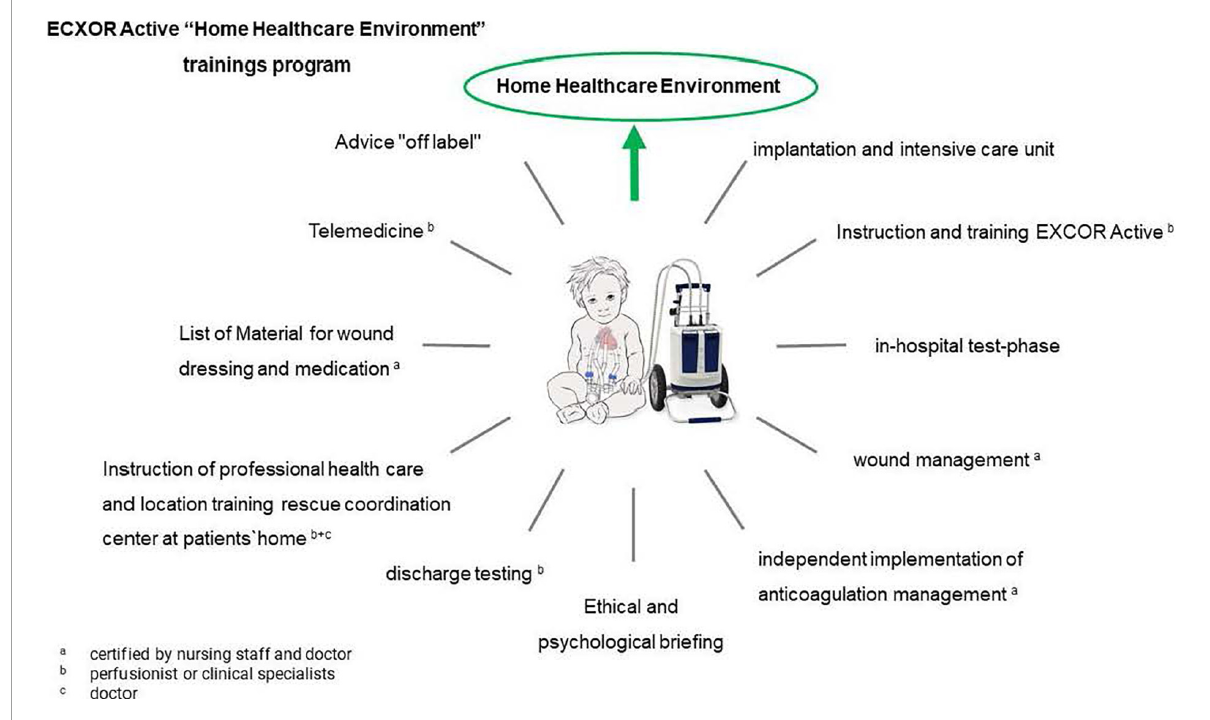
FIGURE3 “Clock of action” until official hospital discharge with EXCOR R (cid:13)